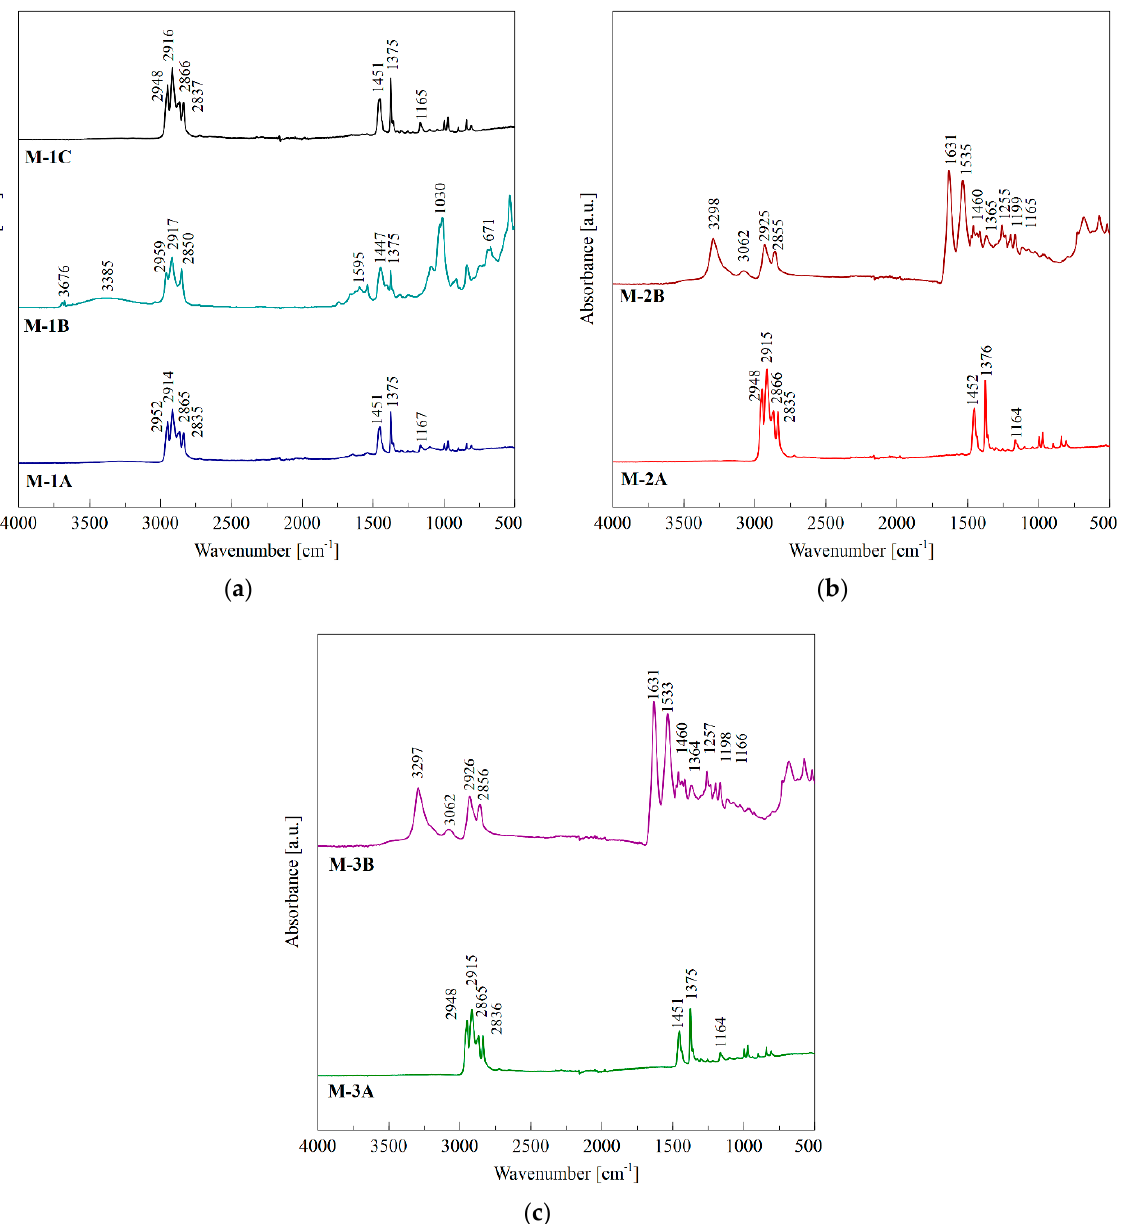
Figure 2. FTIR spectra of different parts of disposable face masks: ( a ) multi-layer mask with an FFP3 breathing valve; ( b ) three-layer mask made by the melt-blown method; ( c ) surgical mask made in China.